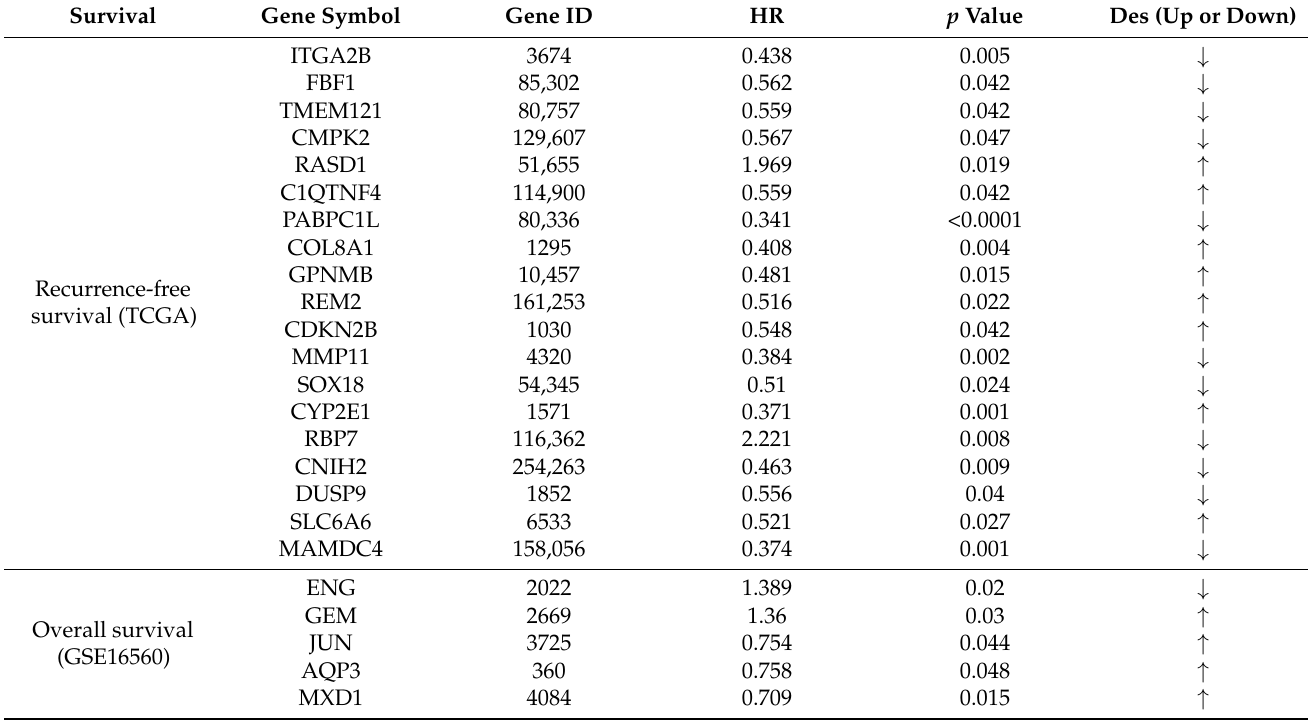
Table 1. Identification of genes and their association with recurrence-free survival (RFS) or overall survival (OS) in prostate cancer. Survival Gene Symbol Gene ID